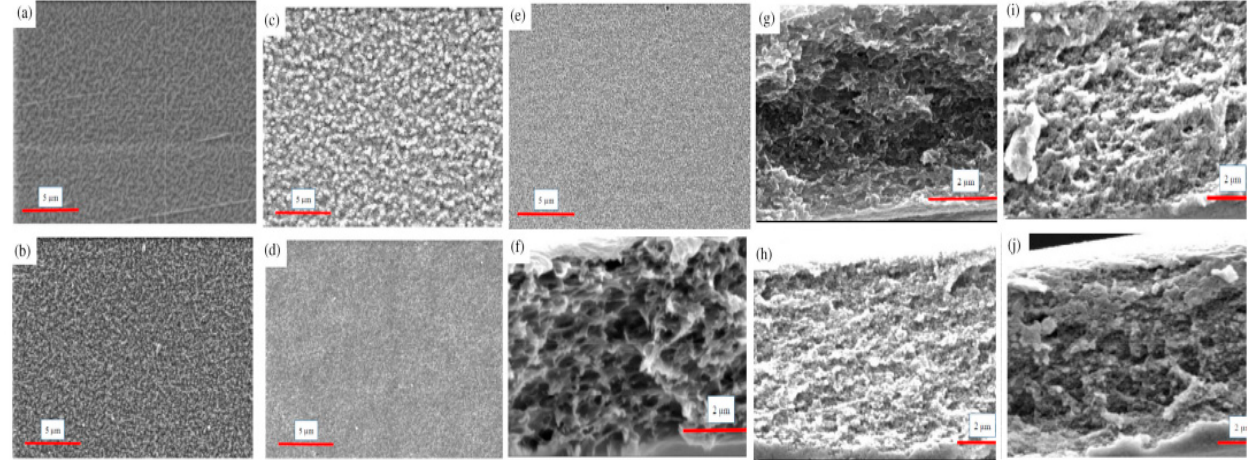
Figure 8. SEM surface images of ( a ) CTA pristine, ( b ) CTA-1 wt.% SiO 2 , ( c ) CTA-2 wt.% SiO 2 , ( d ) CTA-3 wt.% SiO 2 , ( e ) CTA4 wt.% SiO 2 membranes, SEM cross-sectional images of ( f ) CTA pristine, ( g ) CTA-1 wt.% SiO 2 , ( h ) CTA-2 wt.% SiO 2 , ( i ) CTA-3 wt.% SiO 2 , and ( j ) CTA-4 wt.% SiO 2 of membranes. Reprinted with permission from Ref. [286]. Copyright 2020 Prihatiningtyas I. et al.